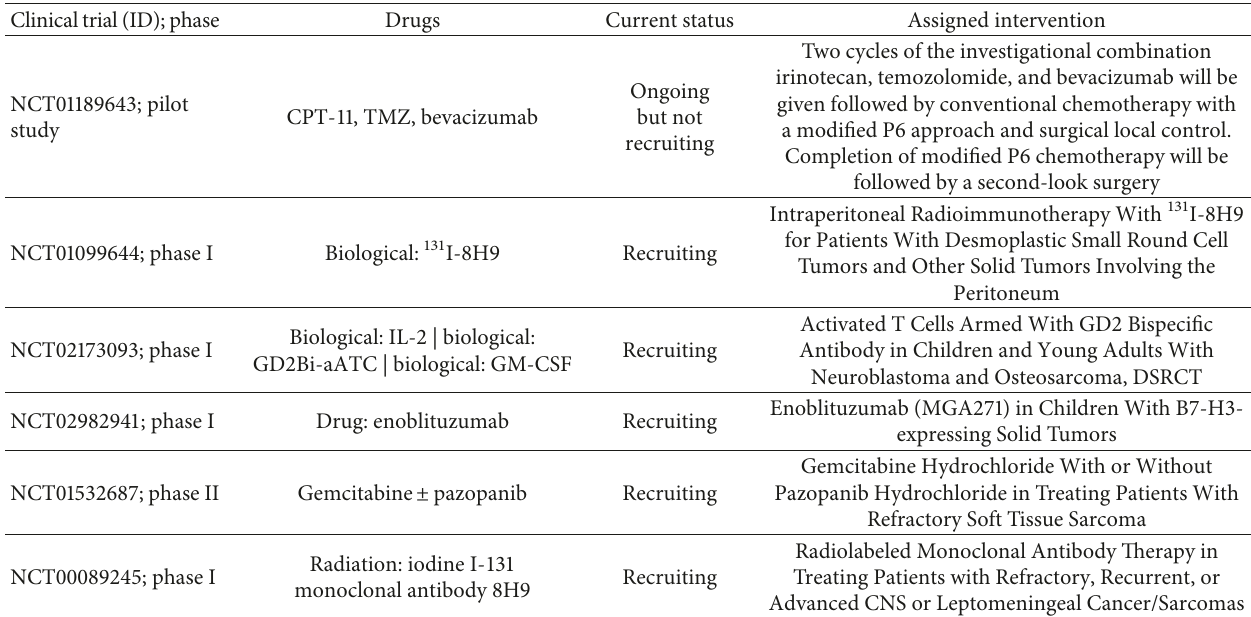
Table 3: Ongoing clinical trials in